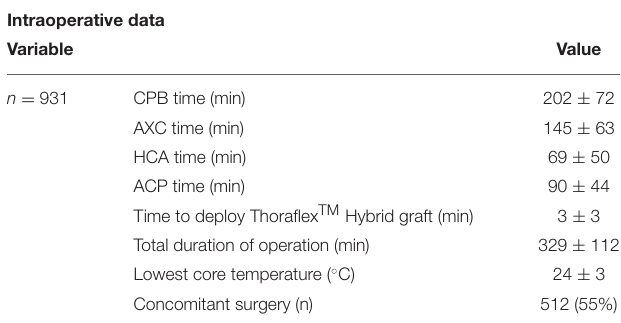
TABLE 2 | Summary of intraoperative data of all 931 patients implanted with Thoraflex TM . Intraoperative